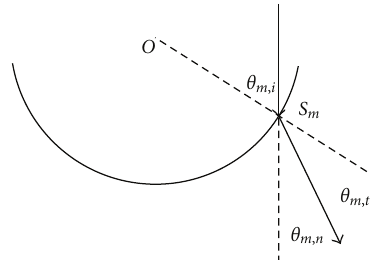
Figure 3: Schematic showing the path of a representative transmit- ted light ray, θ m , t scattered within the wafer.